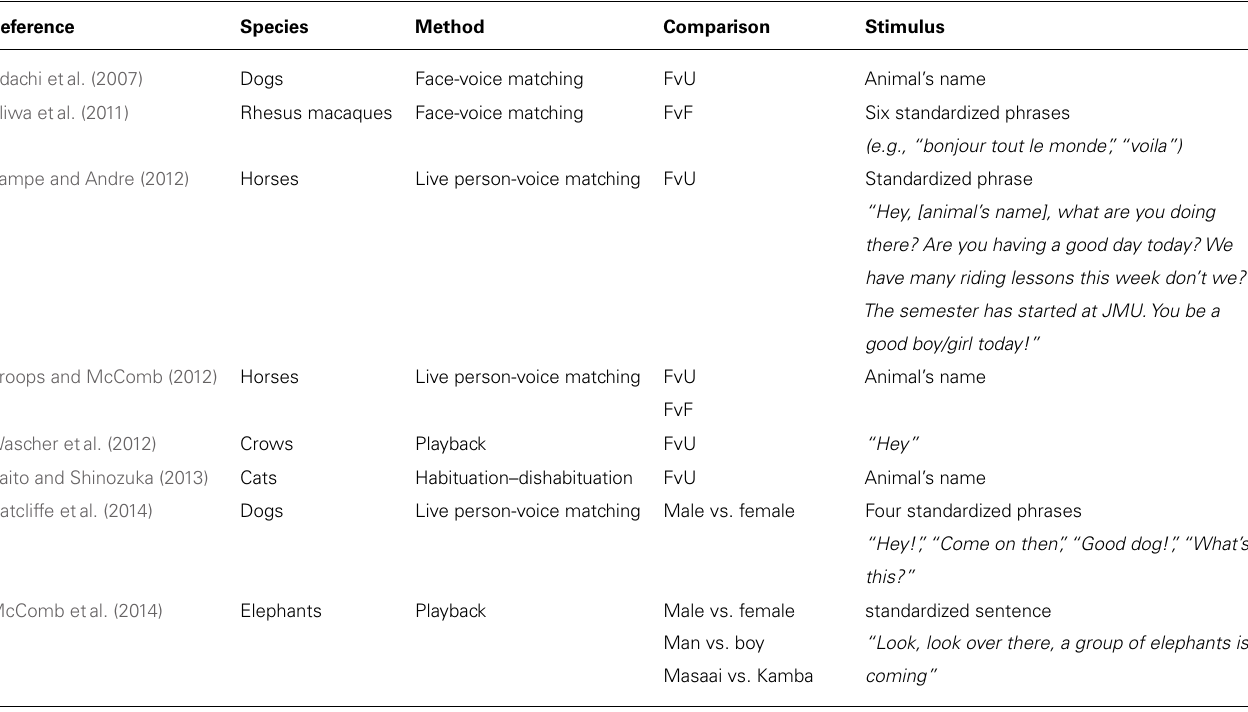
Table 1 | List of studies that have tested animals’ discrimination of different human voices.